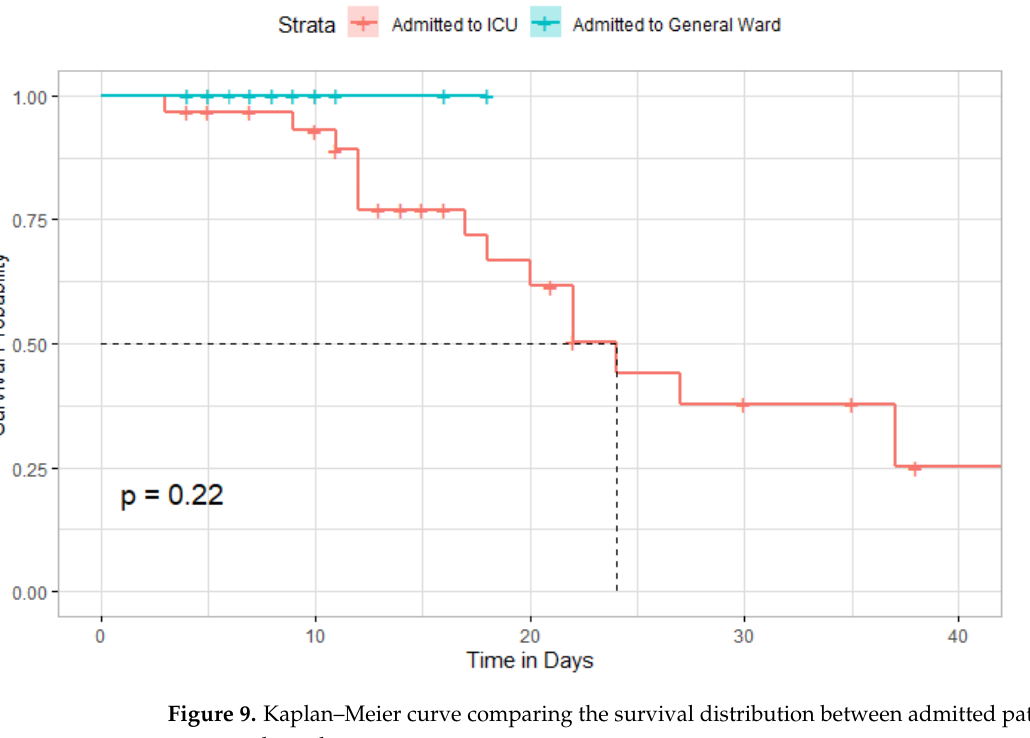
Figure 10. Kaplan – Meier curve comparing the time until viral clearance between ICU admitted pa- tients and general ward.